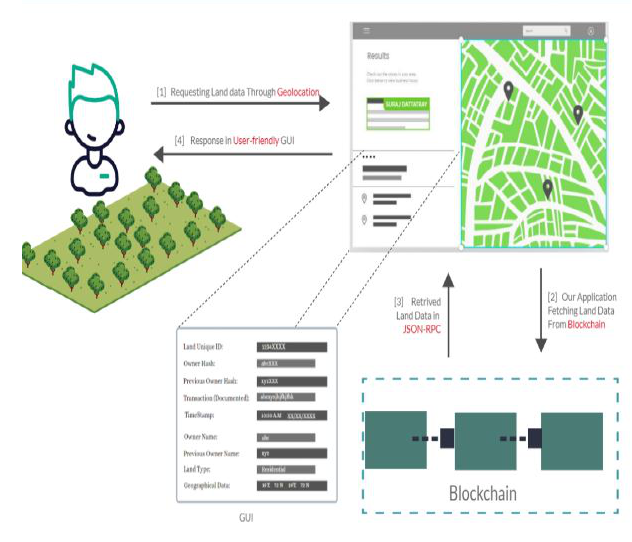
Fig. 3. Flow of User Page.